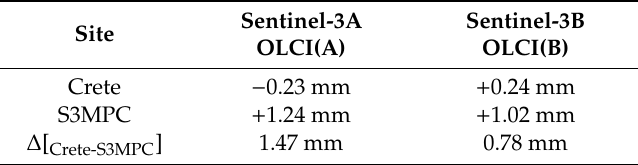
Table 7. Bias of the OLCI(A) and OLCI(B) integrated water vapor measurements as determined in this investigation, using the regional Crete GNSS network and the S3MPC analysis based on the SUOMI-NET GNSS